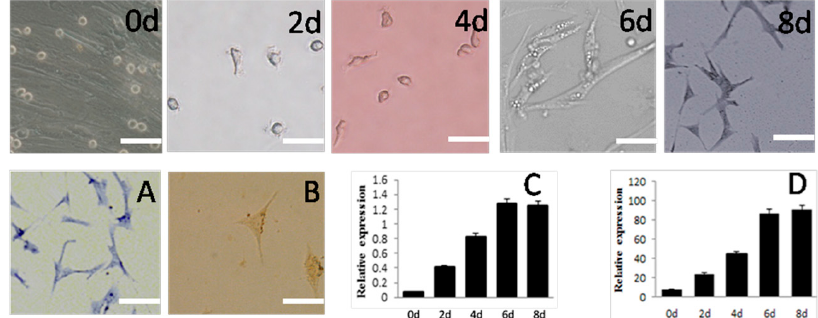
Figure 5. Morphology and gene expression of SSCs differentiated into neuron-like cells in vitro . Appearance under the microscope and various staining properties were used to confirm their identity.Schematic represents the strategy used for in vitro differentiation. 0d, 2d, 4d, 6d, 8d mean the same, 2th, 4th, 6th, 8th day after induction. ( A ) Toluidine blue staining of SSCs-derived cells; ( B ) Immunocytochemcal staining of SSCs-derived cells; ( C ) Expression of Nestin and ( D ) β -tubulin , both measured by mRNA levels during induction . Scale bar: 5 µ m.